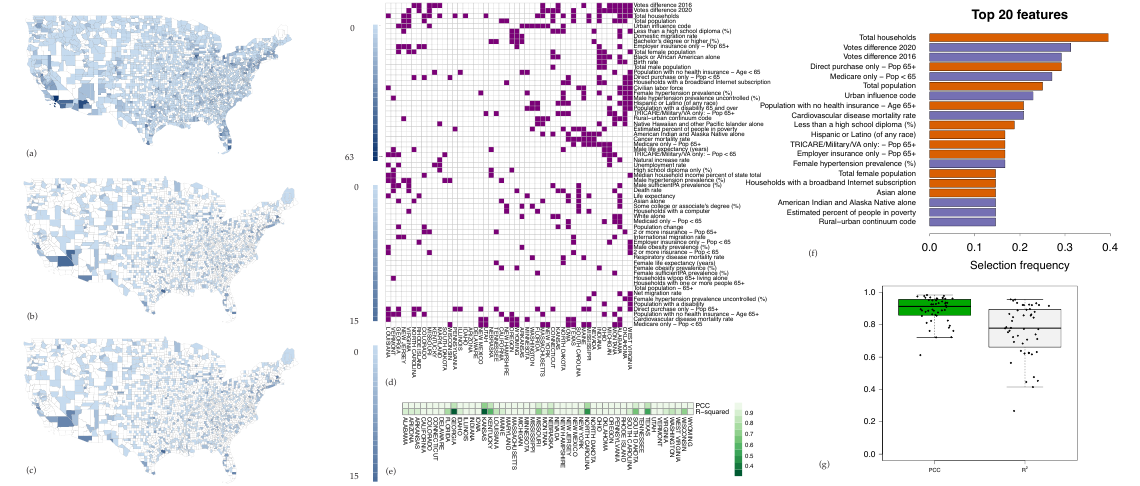
Figure A6. ( a – c ) On three different maps, we presented the data used for training our model for the nationwide phase prediction of deaths, the test data (i.e., holdback, observed) and our predictions for test locations. Deaths were aggregated over the time period after 11 September 2020 until 21 March 2021 in each county in the maps. ( d ) Selected predictive features for each state. ( e ) PCC and R 2 values of the predictions reported as a heatmap per state. ( f ) The most predictive top 20 features selected overall by the algorithm for the nationwide phase. Purple-colored features are negatively correlated with the death counts and the orange-colored features are positively correlated with the case counts. ( g ) PCC and R 2 values of the predictions reported as a box